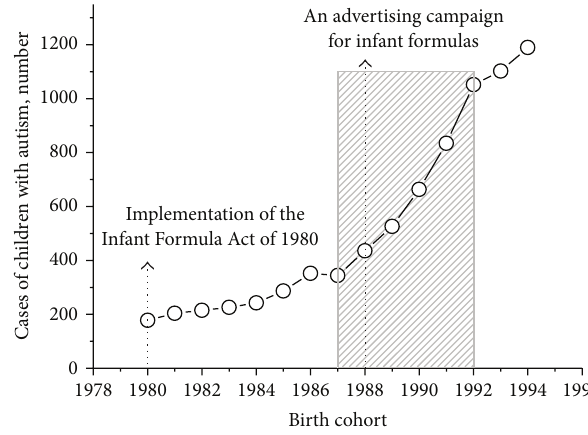
Figure 3: Events related to infant feeding and the prevalence of autism. The data on the number of cases of children with autism in the 1980–1994 birth cohorts in California are taken from [13]. Note that the implementation the Infant Formula Act of 1980 [51] was followed by an apparent increase in autism incidence, while the advertising of infant formula to the general public, started in 1988, was accompanied with a rapid increase in the incidence of autism. The increases were greatest for annual cohorts born from 1987 to